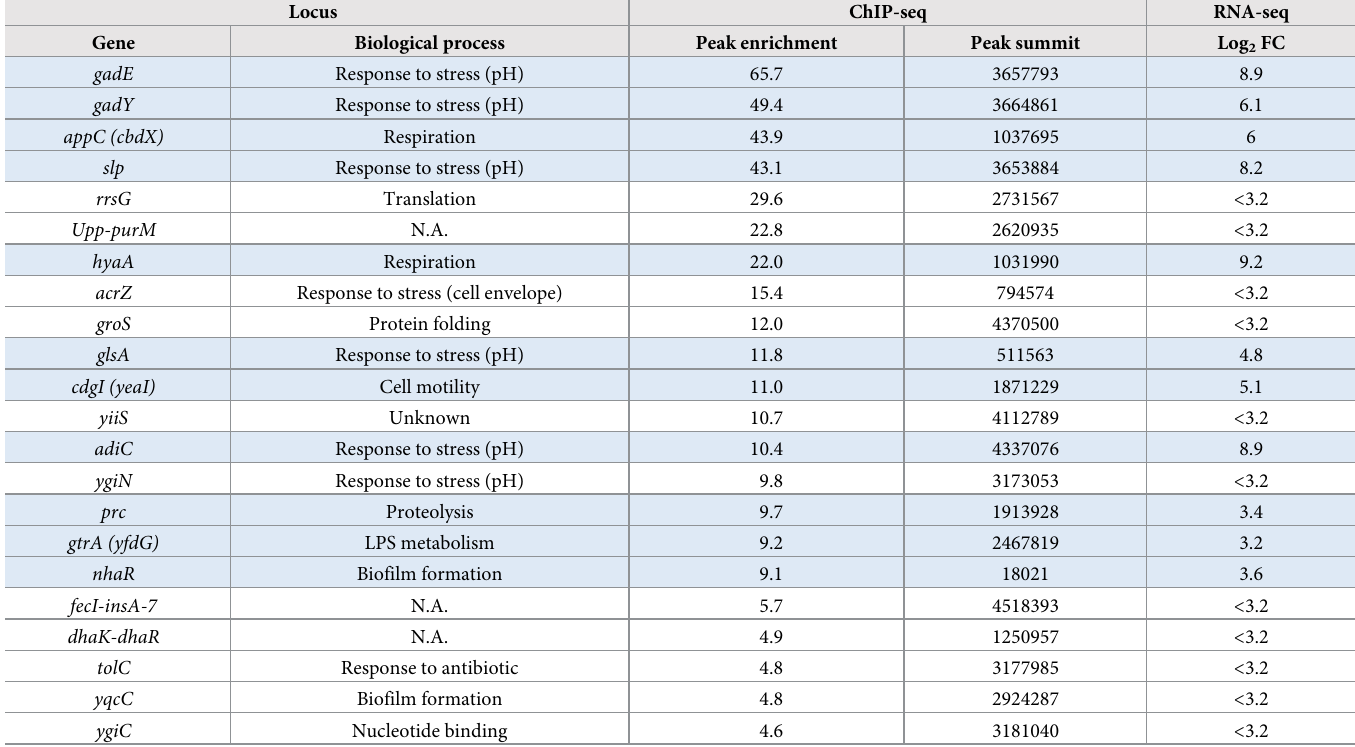
Table 1. AppY direct targets. Gene name, biological process, peak enrichment and peak absolute summit localization of AppY binding region on E . coli str. K12 substr. MG1655 chromosome (accession number U00096.3). In parenthesis are gene synonyms. "-" between two gene names indicates an intergenic binding locus. Biological pro- cesses follow the categories depicted in Fig 1A or one GO number description attached to the gene in Ecocyc when not included in Fig 1A. The differential gene expression computed in the RNA-seq experiment is indicated in the last column. When the fold change is � 10 (log2 FC � 3.2), genes are highlighted in blue (S1 Table). N.A means that the biological process cannot be attributed because the peak summit is between two